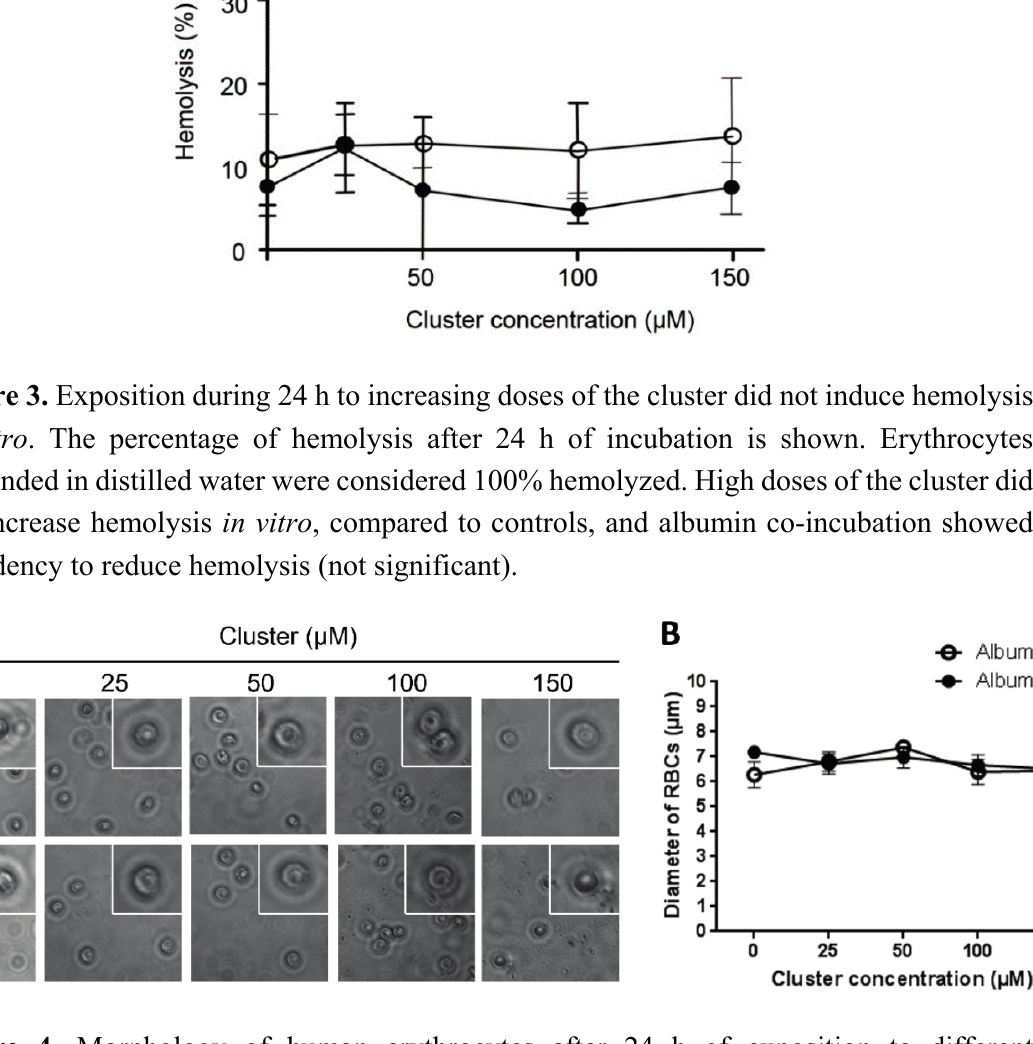
Figure 4. Morphology of human erythrocytes after 24 h of exposition to different concentrations of the cluster with or without albumin. ( A ) Representative pictures of the experimental conditions are shown; and ( B ) The average size of erythrocytes in all conditions is similar, but reduced compared to fresh erythrocytes. Albumin reached similar